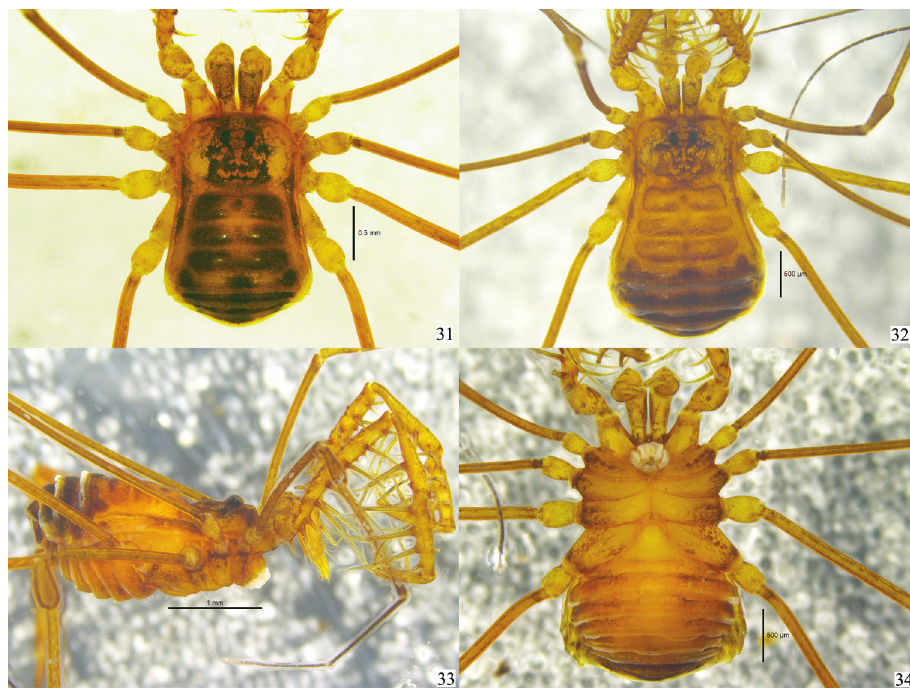
Figures 31–34. Lobonychium palpiplus Roewer, 1938 Photographs of male (MHBU-Opi-20151208m) and female (MHBU-Opi-20151208f) 31 Male body and parts of appendages, dorsal view 32 Female body and parts of appendages, dorsal view 33 Same, lateral view 34 Same, ventral view. Scale bars: 1 mm (Fig. 33); 0.5 mm (Figs 31–32,